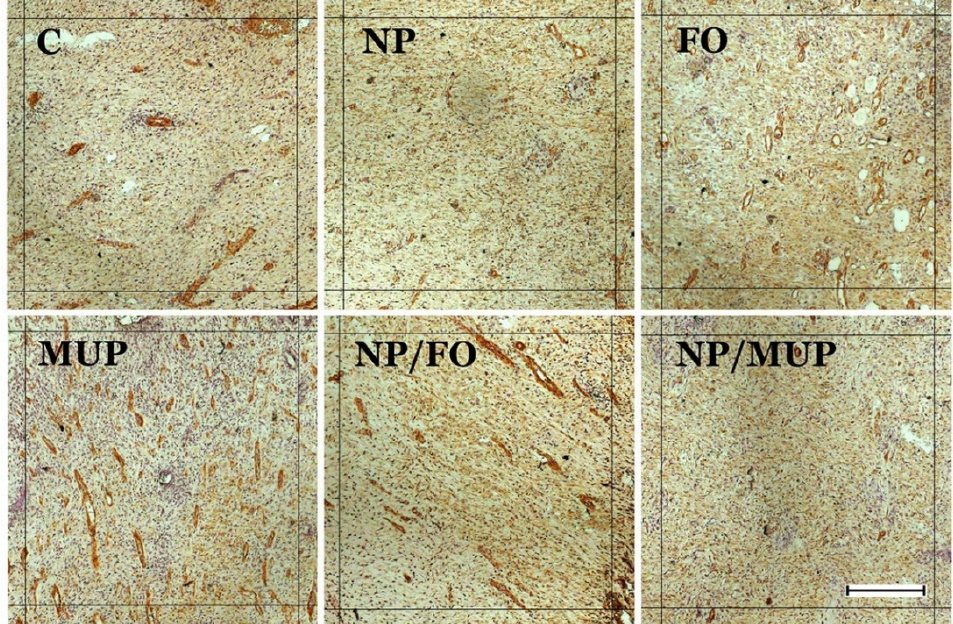
Figure 4. Representative preparations of the healing tissue 14 days post-excision (immunohistochemical labeling of vessels for alpha-smooth muscle actin). C—control (dressing alone); NP—dressing with empty poly(lactic-co-glycolic) acid (PLGA)-polyvinyl alcohol (PVA) nanoparticles (NPs); FO—dressing with fish oil; MUP—dressing with mupirocin; NP/FO—dressing with PLGA-PVA NPs with entrapped fish oil; NP/MUP—dressing with PLGA-PVA NPs with entrapped mupirocin; scale bar = 100 µm.